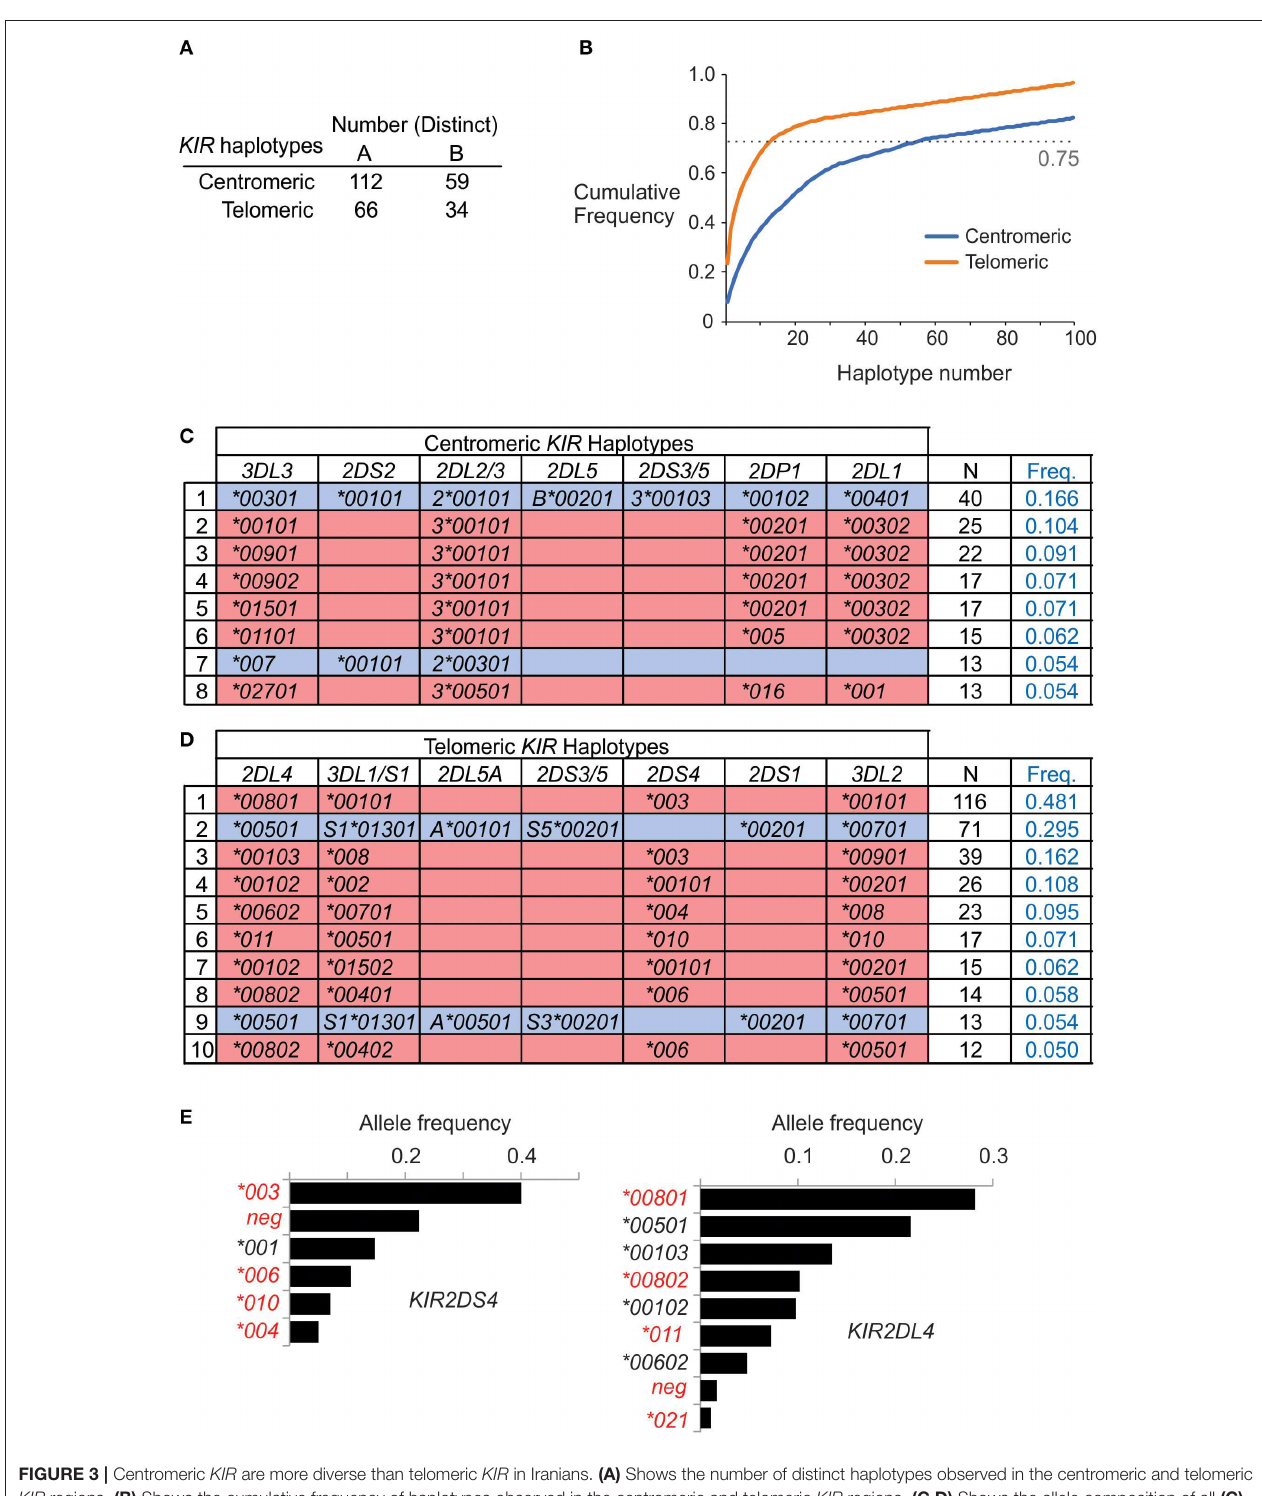
Frontiers in Immunology | www.frontiersin.org